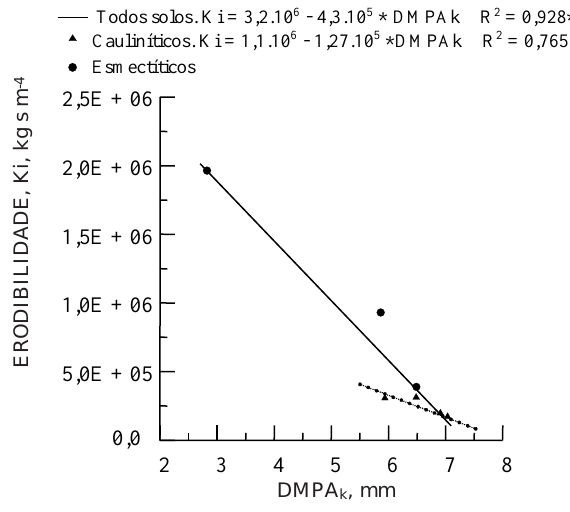
Figura 4. Relação entre a erodibilidade em entressulcos e o diâmetro médio ponderado dos agregados de Kemper & Chepil (1965) (DMPA em amostras de solos do Rio Grande do Sul. A reta (pontilhada) indica o ajuste para os solos cauliníticos.